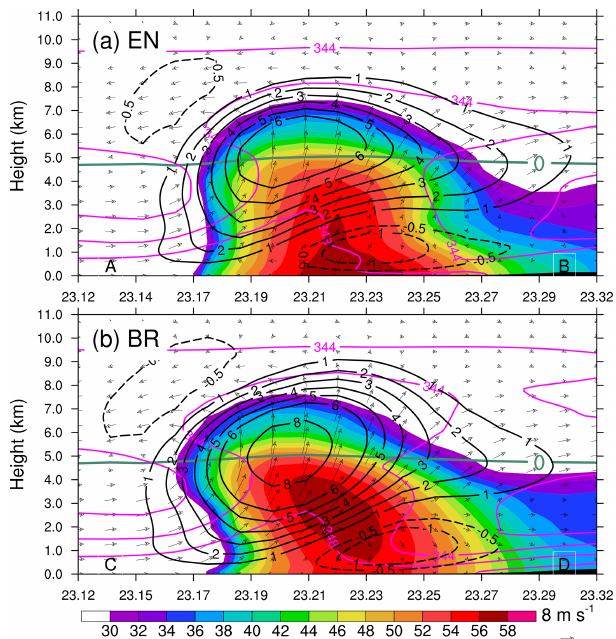
Figure 7. Temporally averaged vertical cross-sections along (a) A–B and (b) C–D in Fig. 6 of the simulated reflectivity (dBZ; shadings), vertical velocity (black contours; ms − 1 ), in-plane flow vectors (vertical motion amplified by a factor of 2), and θ e (pink-contoured at 4K intervals) during the period from 06:00 to 07:00BST 7 May 2017. The thick light-green line indicates an isotherm of 0 ◦ C.